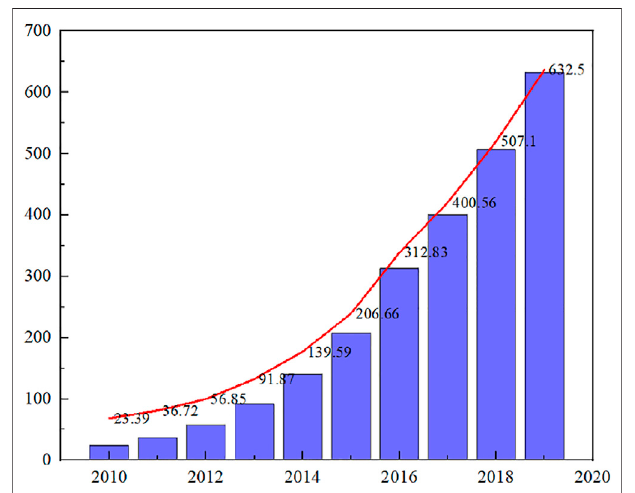
FIGURE 1 | Statistics of China ’ s express business volume from 2010 to 2019.